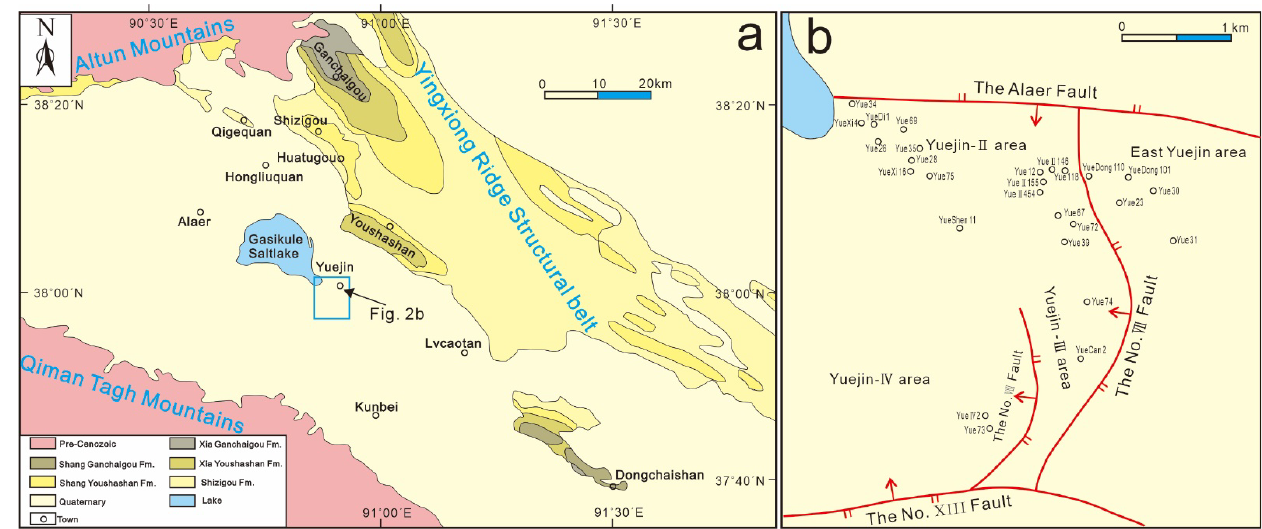
Figure 2. ( a ) Regional geological sketch of southwestern area of the Qaidam Basin and its adjacent orogenic areas (modified after [69]) and ( b ) schematic geological map of the Yuejin area to the main controlled faults and representative oilfield holes (modified after [70]).